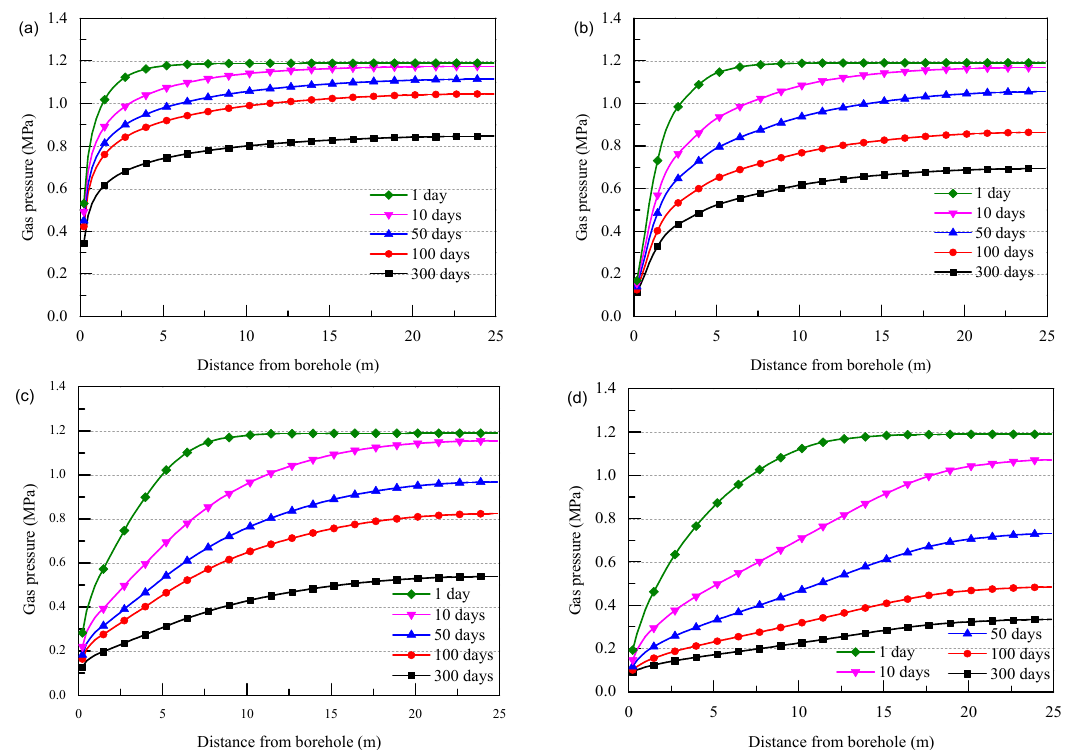
Figure 10. Variation of gas pressure on reference line O-B with extraction time: ( a ) D-CBM, ( b ) A-ECBM, ( c ) F-ECBM, ( d ) AF-ECBM.